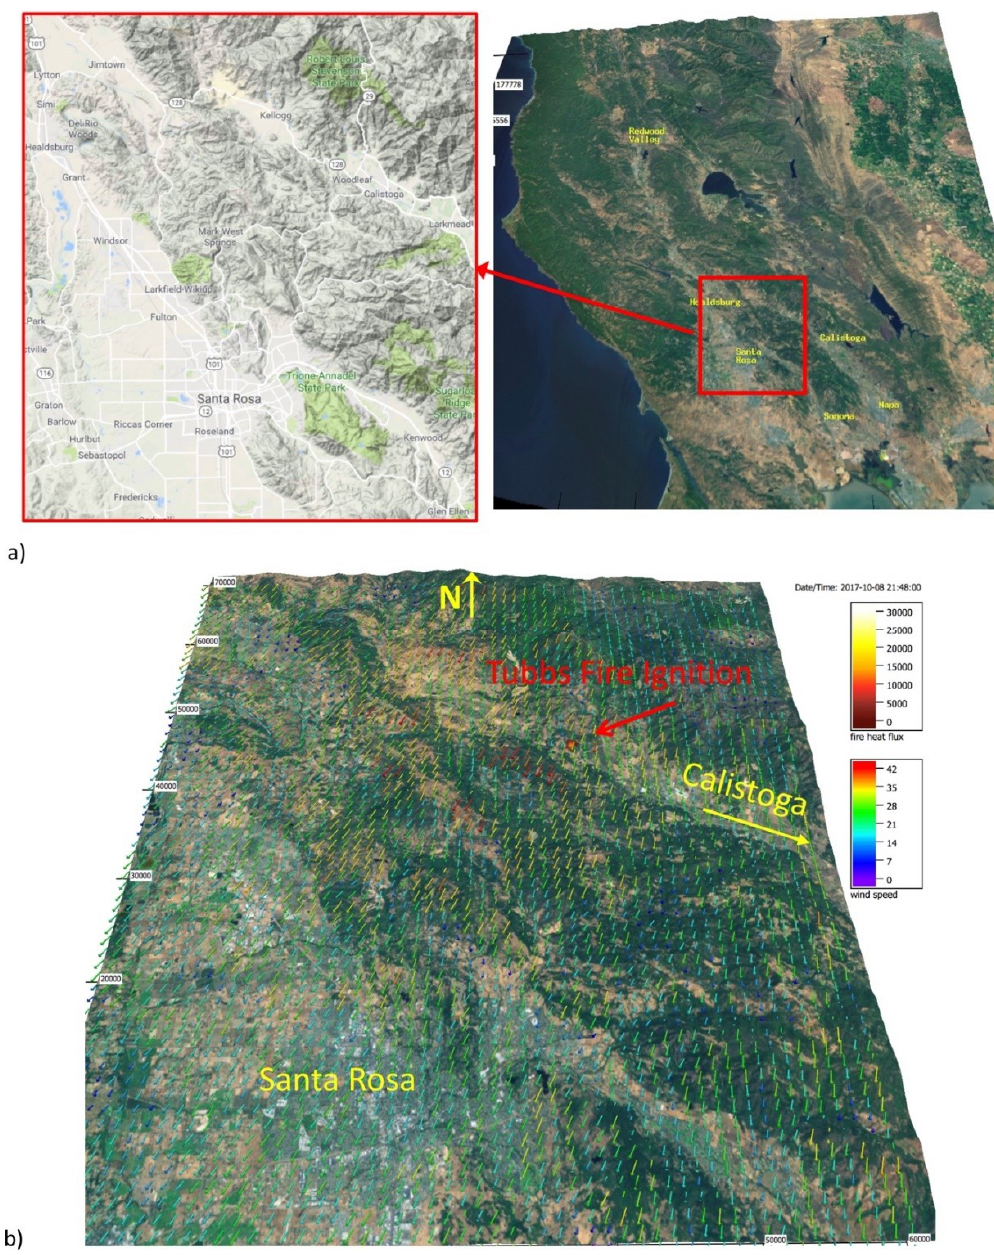
Figure 9. ( a ) Geographical extent and location of domain 4; ( b ) Simulated near-surface winds (8.5 m above ground level) on 8 October at 9:48 p.m. in domain 4. Wind speed arrows point downstream and are colored according to the color bar at right (in m/s). Vectors are shown every three grid points.